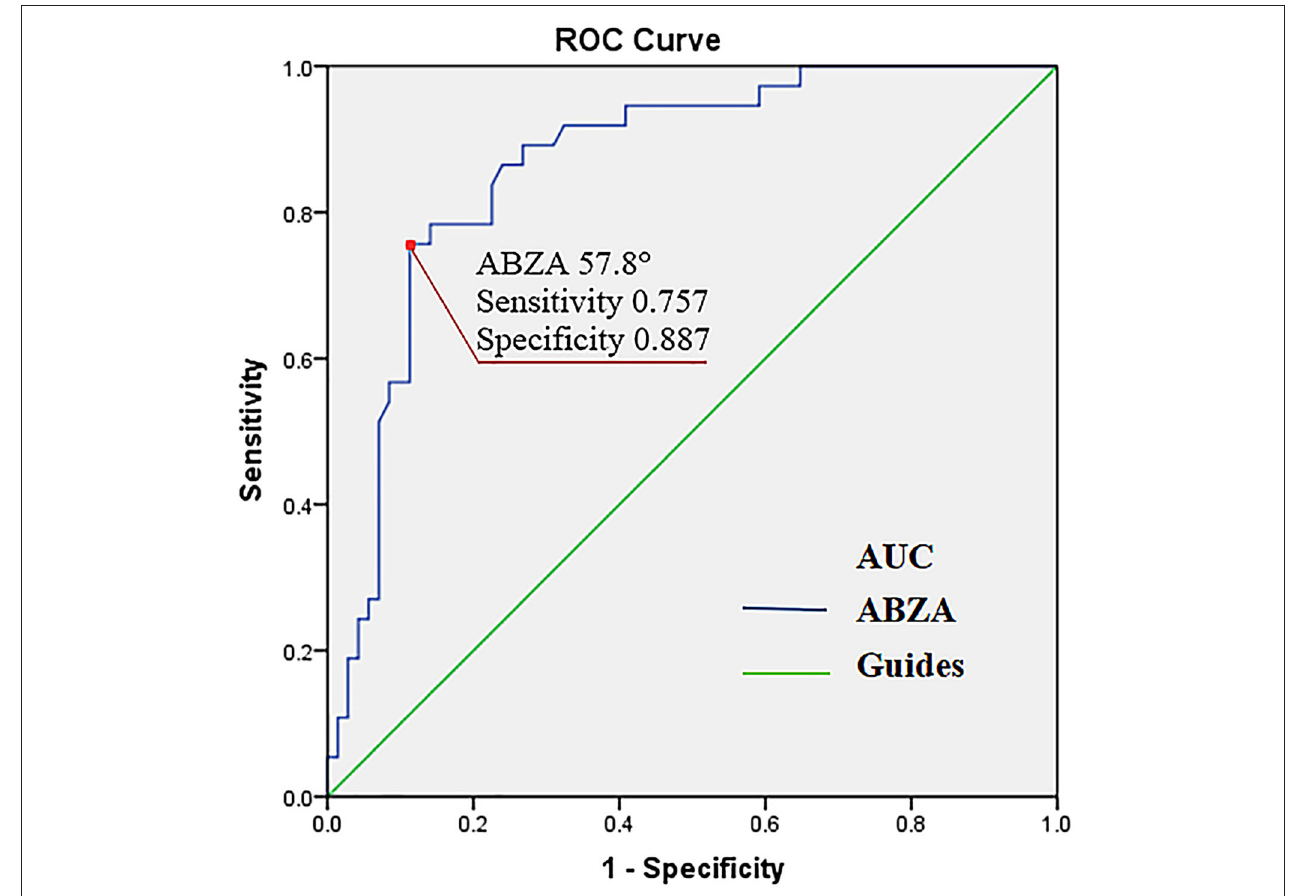
FIGURE 4 | Receiver operating characteristic curve (ROC) of ABZA predicting a favorable 90-day clinical outcome. The area under ROC curve (AUC) of ABZA was 0.868 (95% CI: 0.79–0.938; P < 0.001). For an ABZA of > 57.8 ◦ (corresponding ABZA-grading of > 2), the predictive sensitivity and specificity were 75.7 and 88.7%, respectively (the red point). ABZA, anterior borderzone